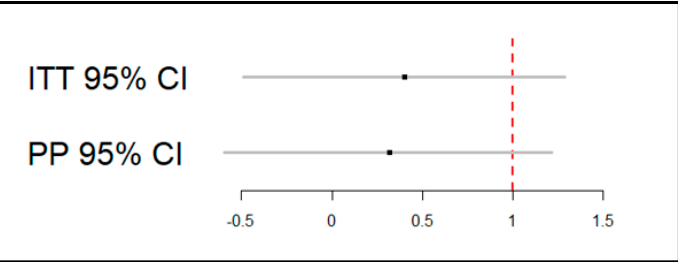
Figure 2. Non-inferiority margin. CI, confidence interval; ITT, intention-to-treat; PP, per-protocol. The changes in NRS scores for the three groups over time are shown in Table 2. NRS Except for PONV, the frequency of adverse effects, such as dizziness and drowsiness, showed significant differences among the three groups (Table 3). However, patient sat- isfaction, QoR-40 scores, and BPI results for each time period did not show significant differences among the three groups (Tables S1 and S2). Table 2. Change in numerical rating scale (NSR) scores in the three groups over time and the dose of patient-controlled analgesia. Group F Group F Group N Group F Group N Group NF vs. N vs. NF vs. Overall- p